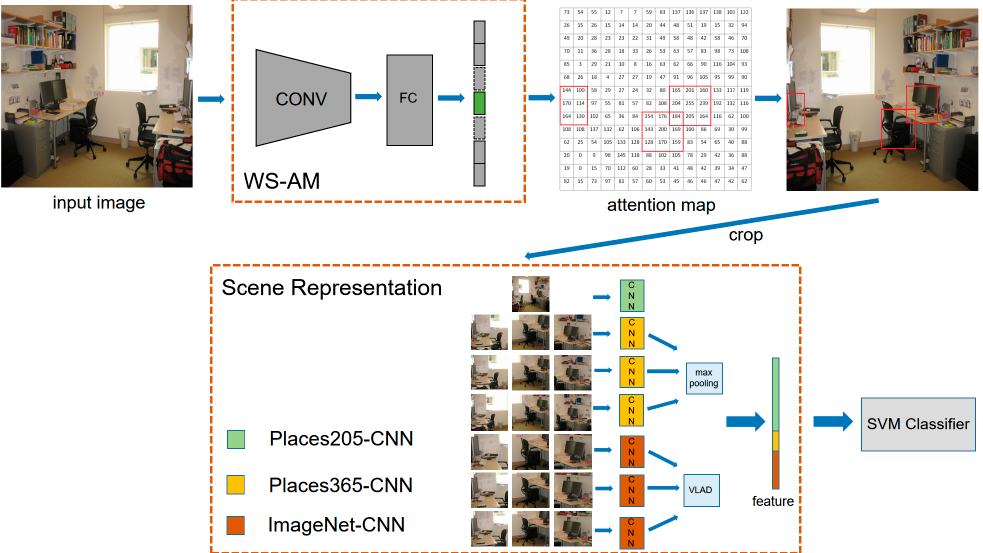
Figure 3. The framework of our method. The framework can be divided into two parts: WS-AM and scene representation.